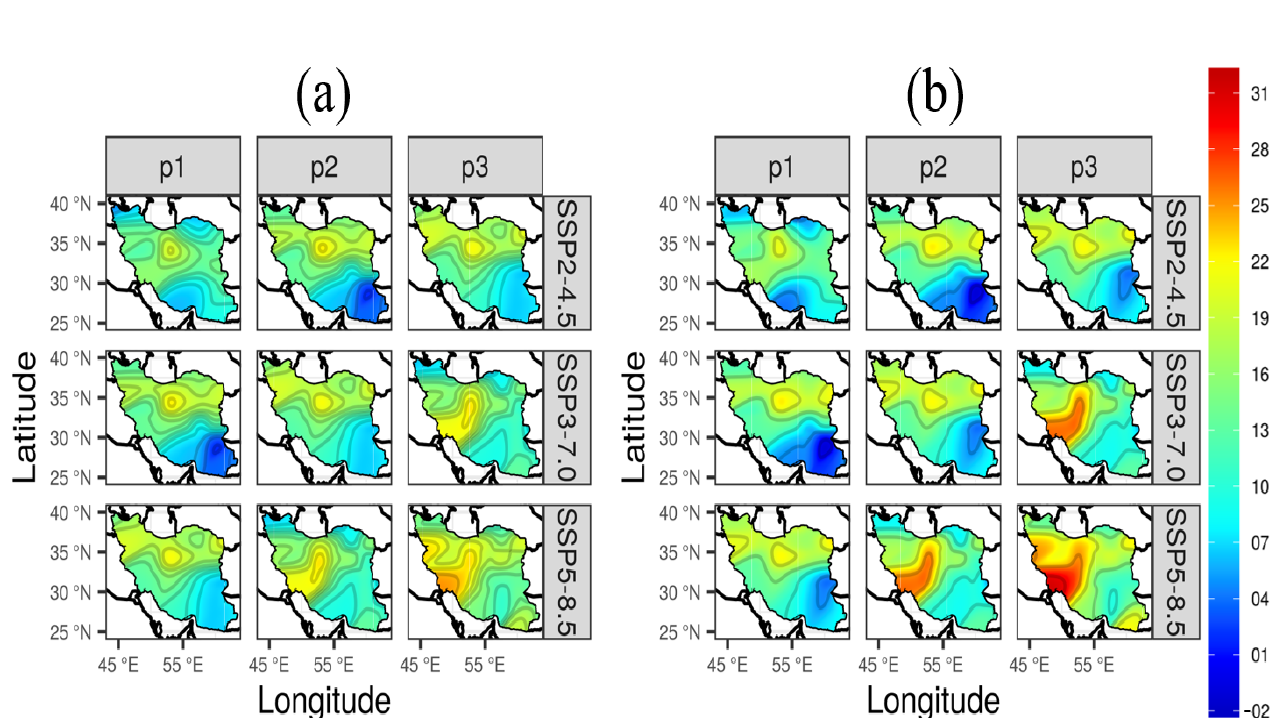
Figure 7. Isopluvial maps of for the relative changes (unit: %) of ( a ) 20-year and ( b ) 50-year return levels relative to 1971–2014 for the annual largest daily rainfall for 47 grids over Iran for the future periods P1 (2021-2050), P2 (2046-2075), and p3 (2071-2100) under the SSP2-4.5, SSP3-7.0, and SSP5-8.5 scenarios.